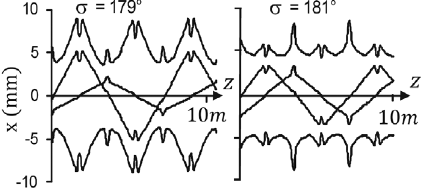
FIG. 16. Plot of the envelope flip for two matched solutions around σ ¼ 180